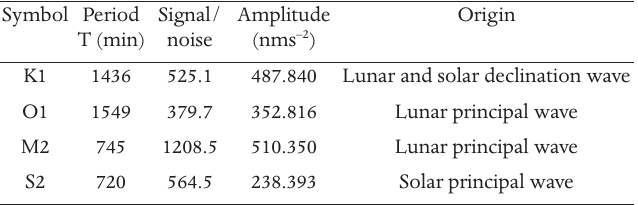
Table 1. The strongest components of the Earth tides in